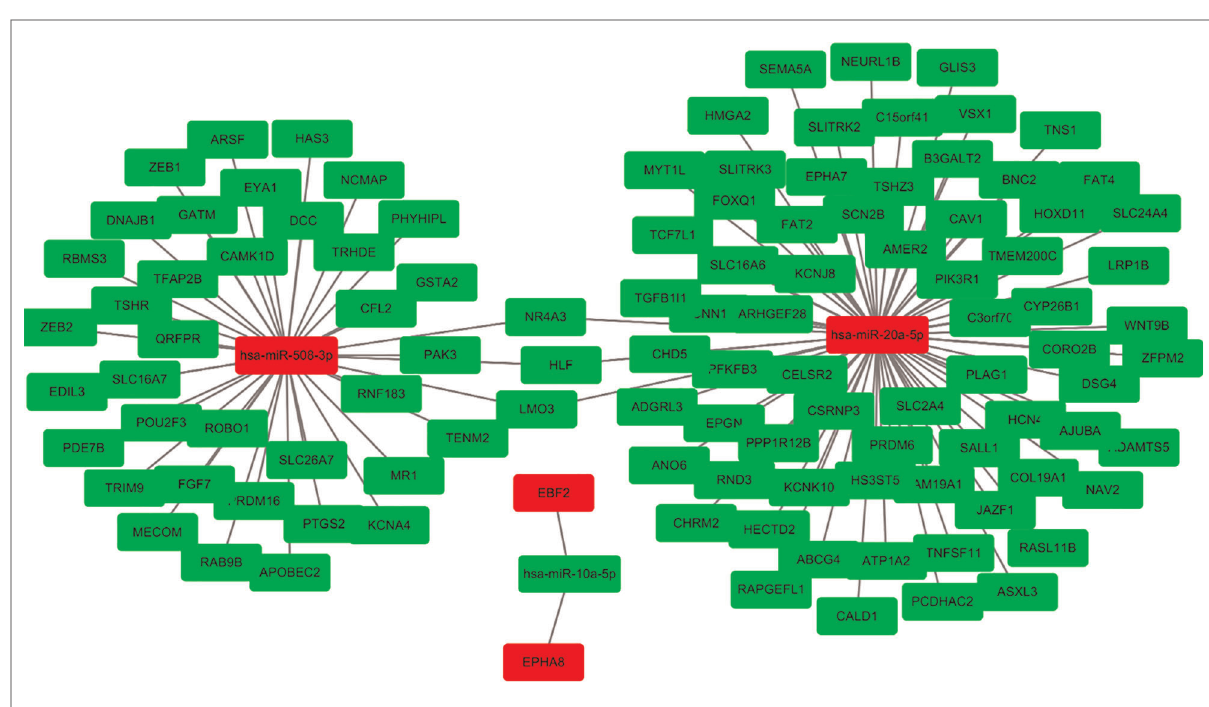
FIGURE 7 Relationships between the sDMIRs and target genes. The sDMIRs and target gene regulatory network. Red parts represent upregulated genes, and green parts represent downregulated